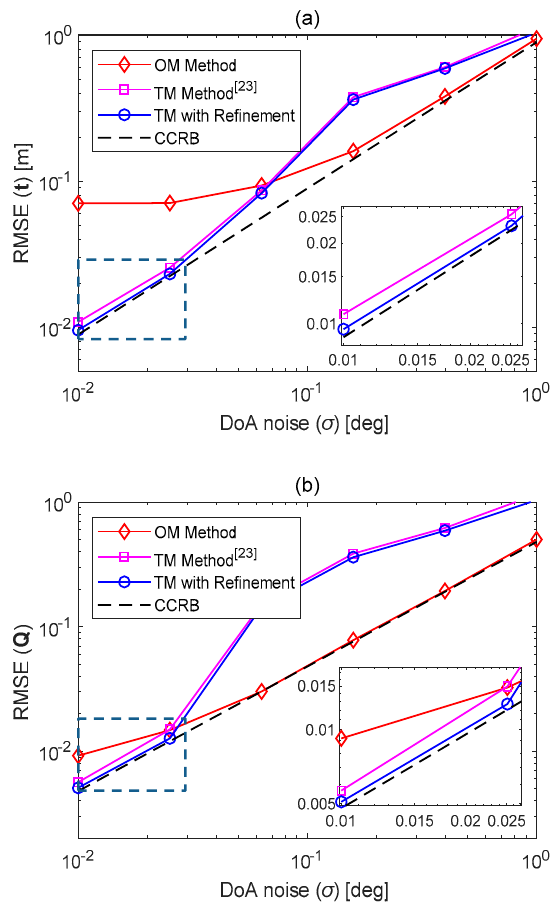
Figure 3. Comparison of root mean squared errors (RMSEs) of ( a ) the estimated translation vector and ( b ) the estimated rotation matrix, when D = 1 m. Note: OM = observation matching; TM = topology matching; and CCRB = constrained Cramér–Rao bound.